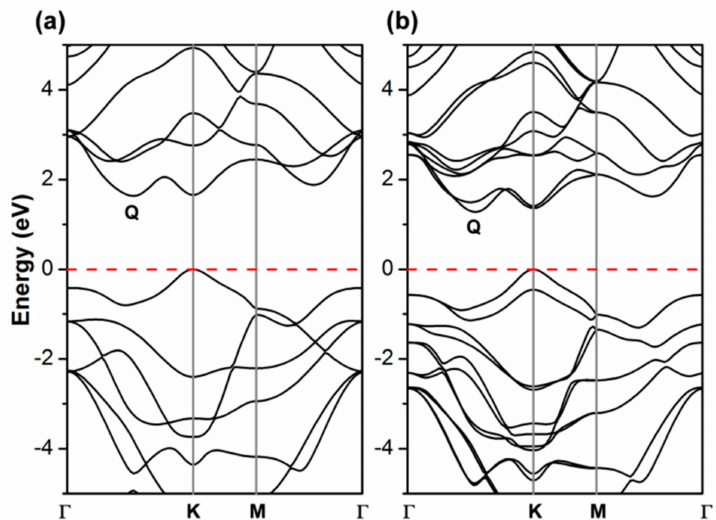
Figure 3. Band structure of monolayer WSe 2 unit cell obtained by Perdew-Burke-Ernzerhof/Quantum ESPRESSO (PBE/QE) with ( a ) and without ( b ) spin–orbit coupling. The Fermi level is scaled to zero (the top of valence